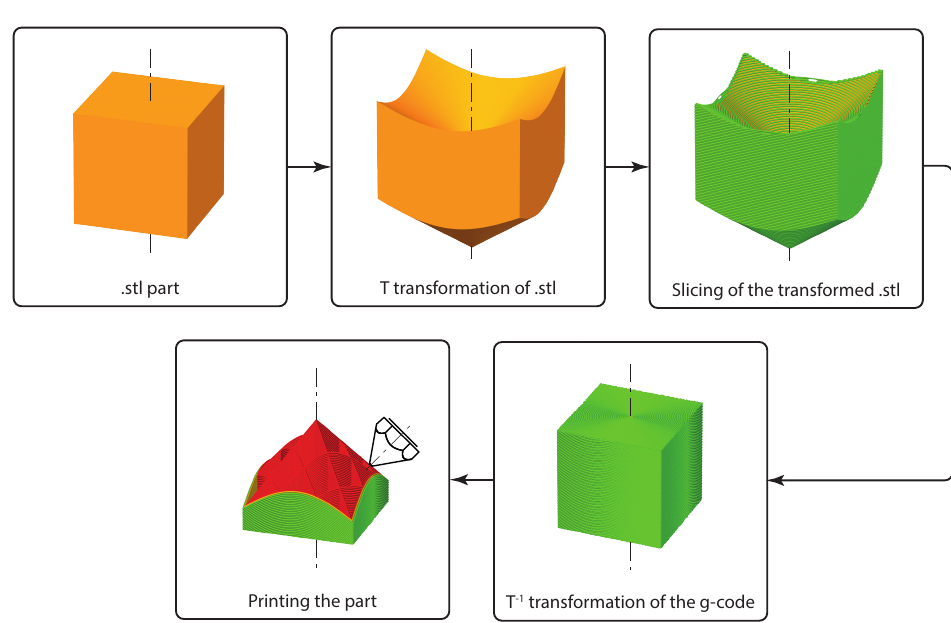
Figure 5. Workflow architecture of the slicing